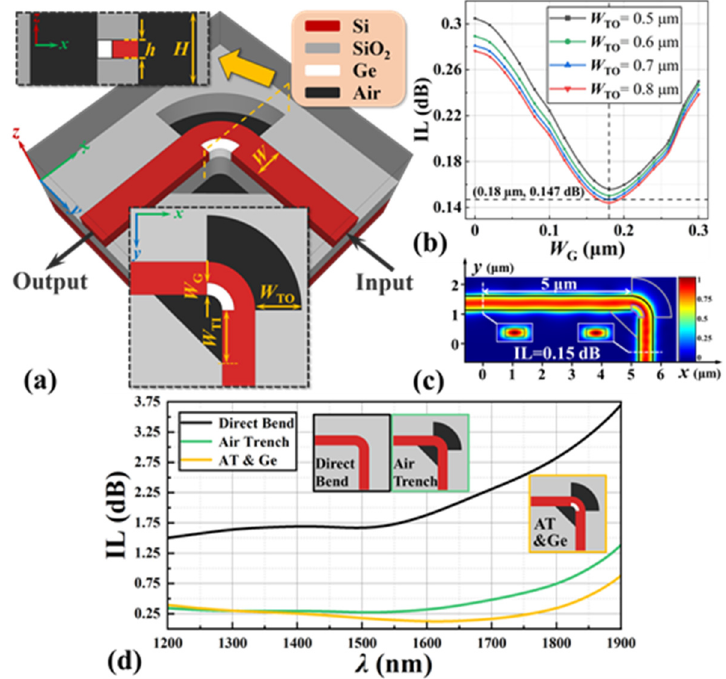
Figure 3. ( a ) Schematic of the silicon waveguide bend with two air trenches on both sides and embedded with a 90 ◦ arc made of Ge in the inner side. Insets show the enlarged views of the designed bend. ( b ) Device IL dependent on the Ge arc width W G and outside air trench width W TO . ( c ) Electric field evolution (| E |) through the proposed waveguide bend, where | E | stands for the norm of electric field. ( d ) Wavelength spectrum of IL for the proposed waveguide bend together with that for the direct waveguide bend and waveguide bend with air trenches. AT: Air Trench.